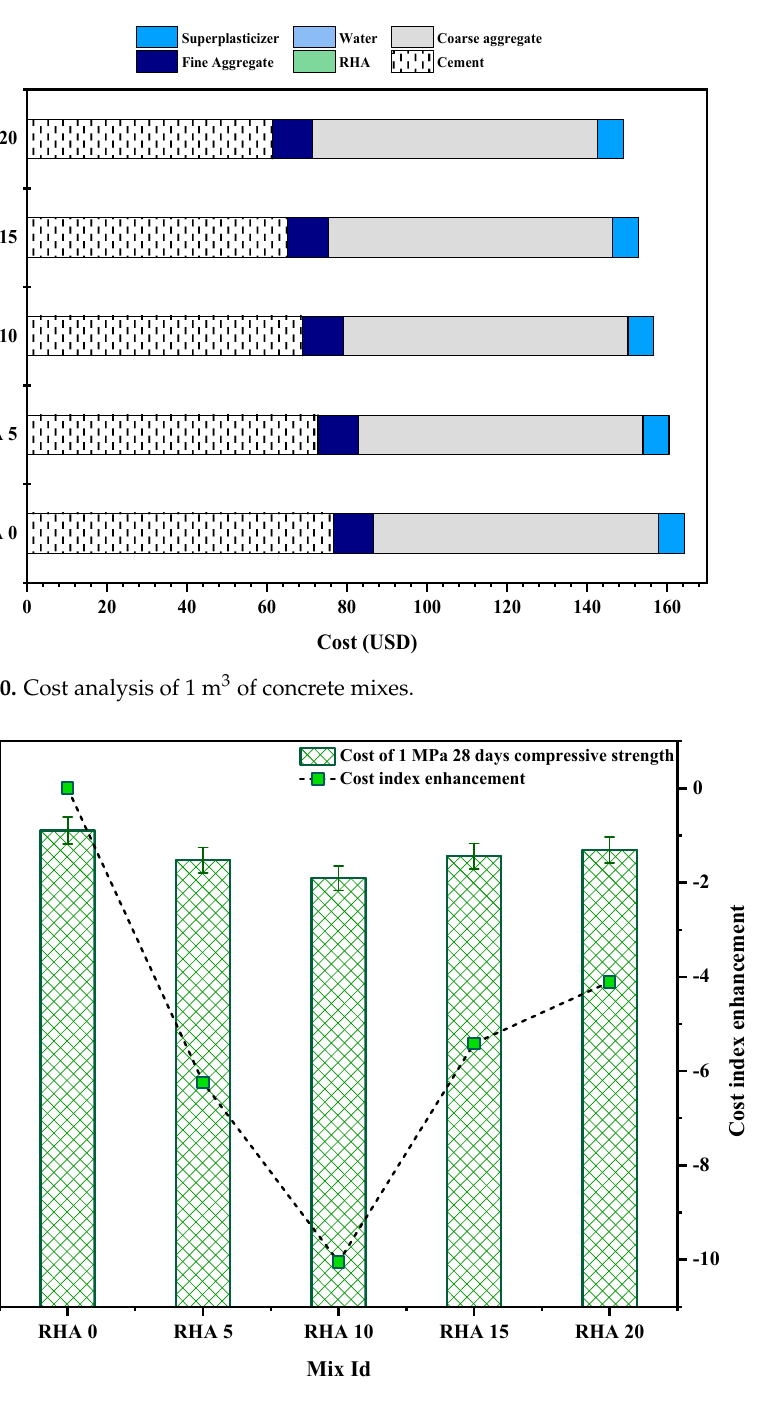
Figure 21. Cost index of the mixes.